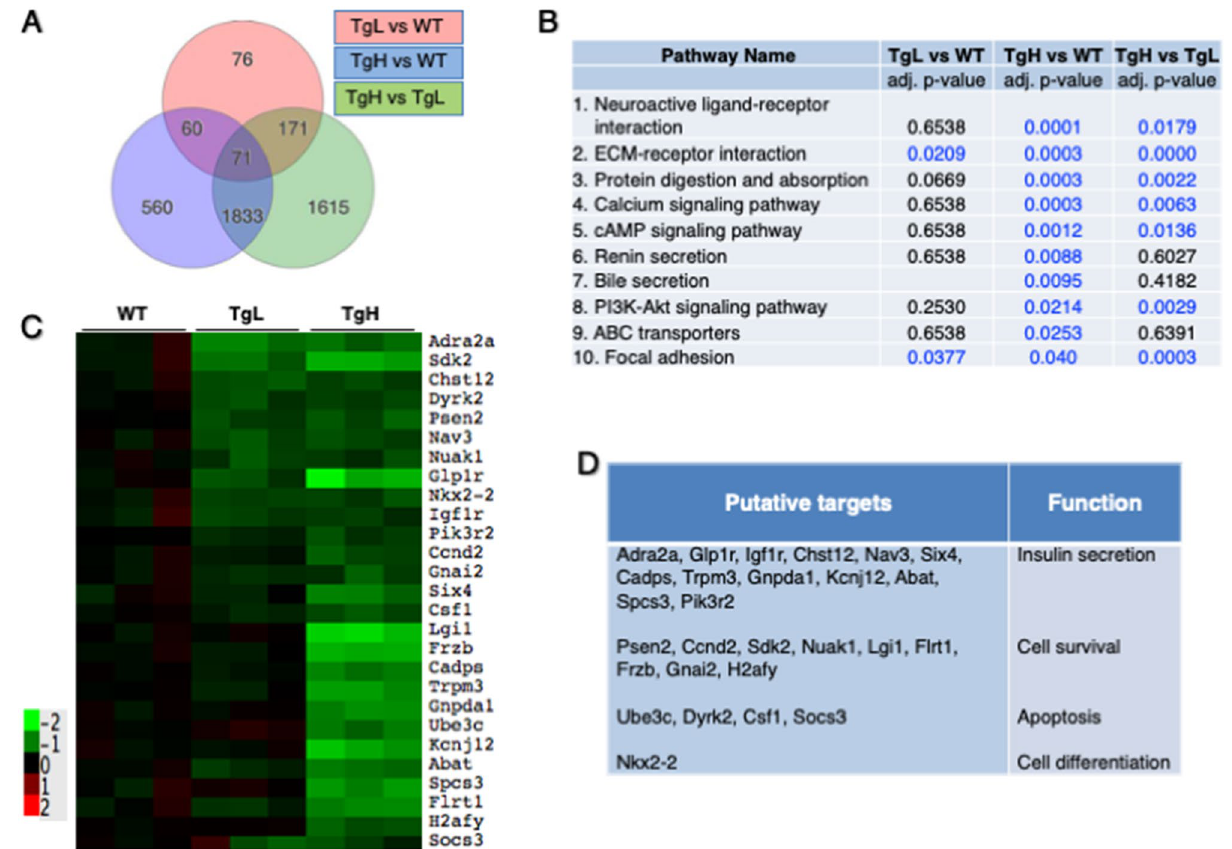
Figure 5. RNA sequencing revealed differentially expressed (DE) genes in transgenic and control mice. Differentially expressed genes (false discovery rate < 0.01) between WT, TgL and TgH mice (n = 3 mice in each group) were generated by RNA-sequencing using Illumina HiSeq 4000. ( A) Proportional Venn diagram representing the number of DE genes in TgL, TgH or both (overlap). ( B) Gene ontology analysis revealed top 10 significantly enriched “biological pathways”. Data were analyzed by Fisher/binominal test with Bonferroni- adjusted p value. The numbers highlighted in blue represent the designated significance threshold (* p < 0.05). ( C ) A heatmap of expression levels of putative target genes of miR-30d identified by intersecting DE genes with miRNA TargetScan databases. Color scale represents their expression across groups. ( D ) List of selected target genes and their